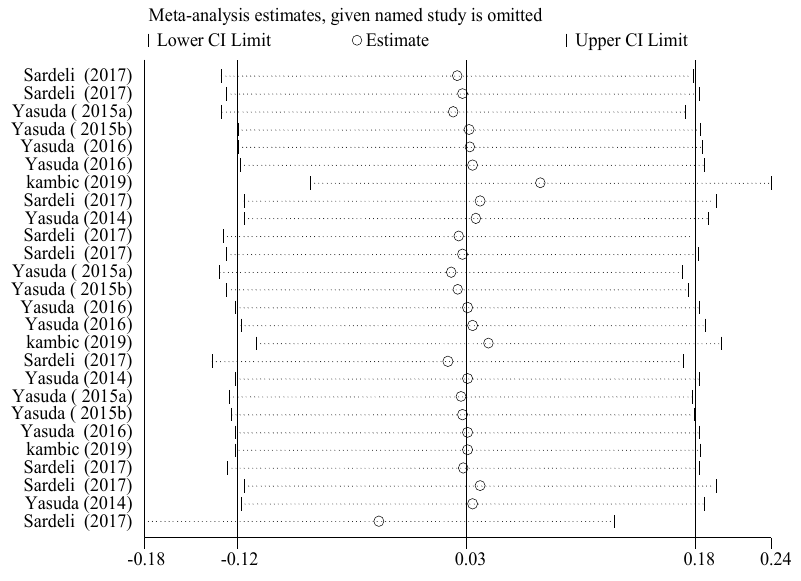
Figure 10. Sensitivity analysis for resting hemodynamic outcomes.